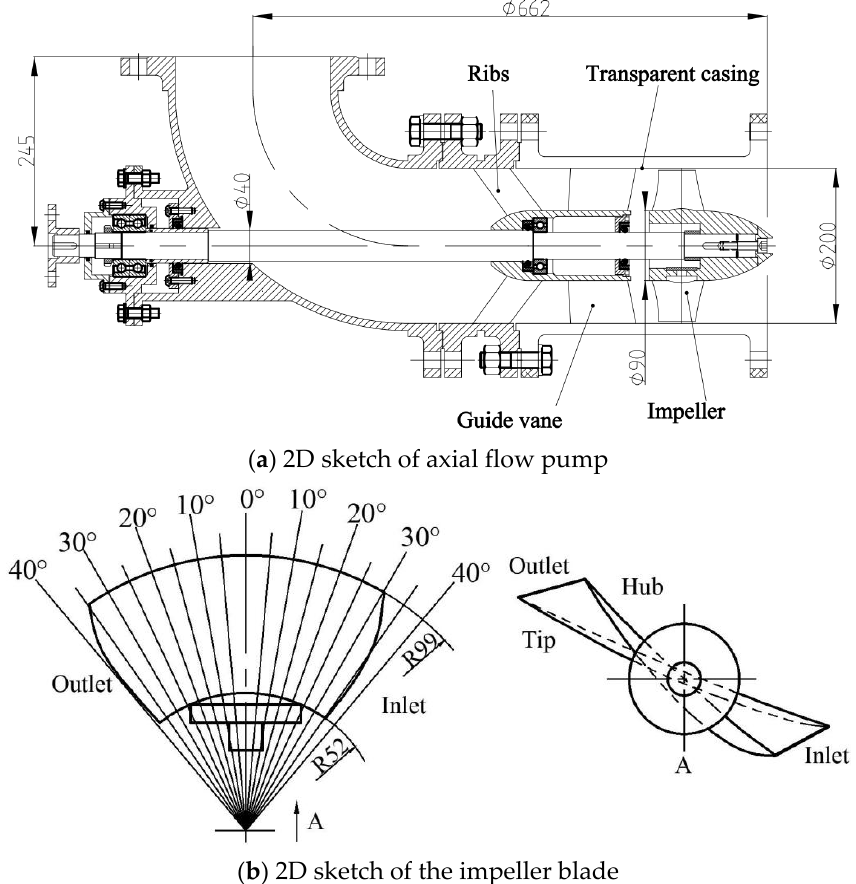
Figure 1. Axial flow pump structure composition and geometric parameters.